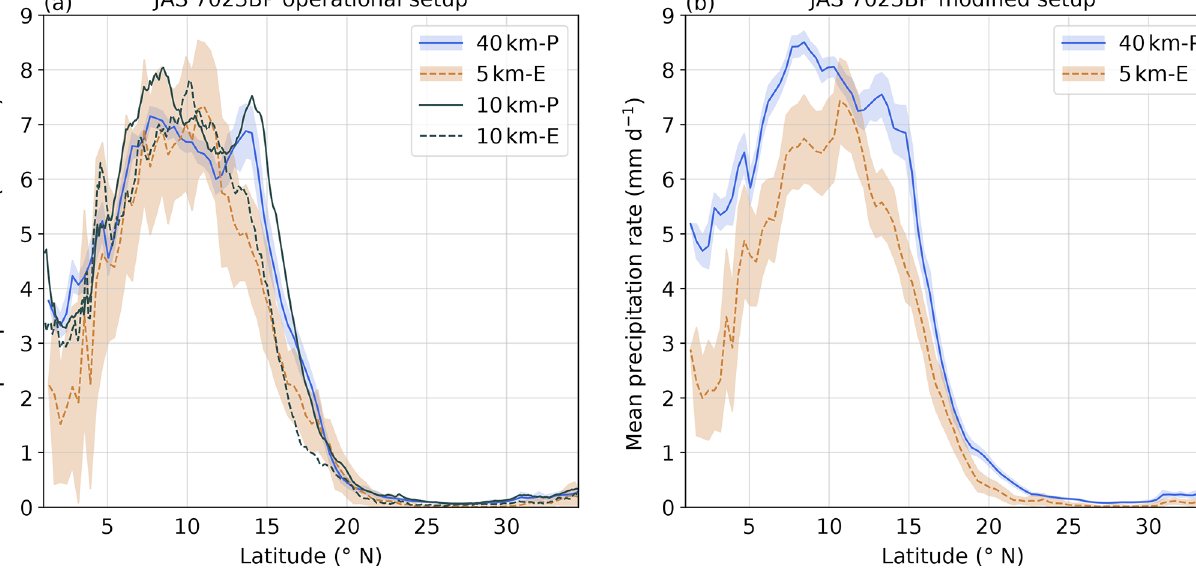
E simulations. The analysis was repeated for the 10 km-P and 10 km-E simulations and can be found in Appendix